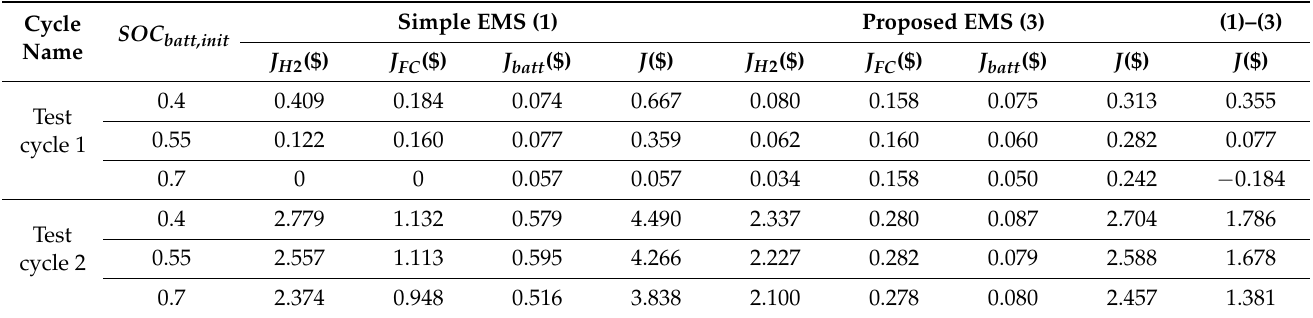
Table 5. Trip costs of the simple EMS and the proposed-based EMS for the test cycles.